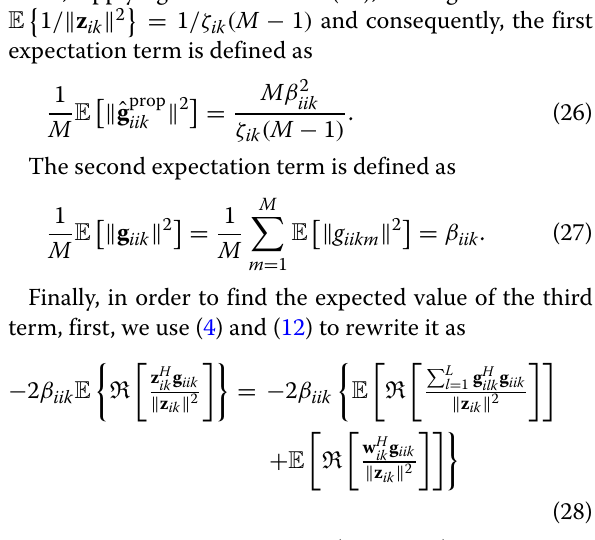
Figueiredo etal. EURASIPJournalonWirelessCommunicationsandNetworking (2018)